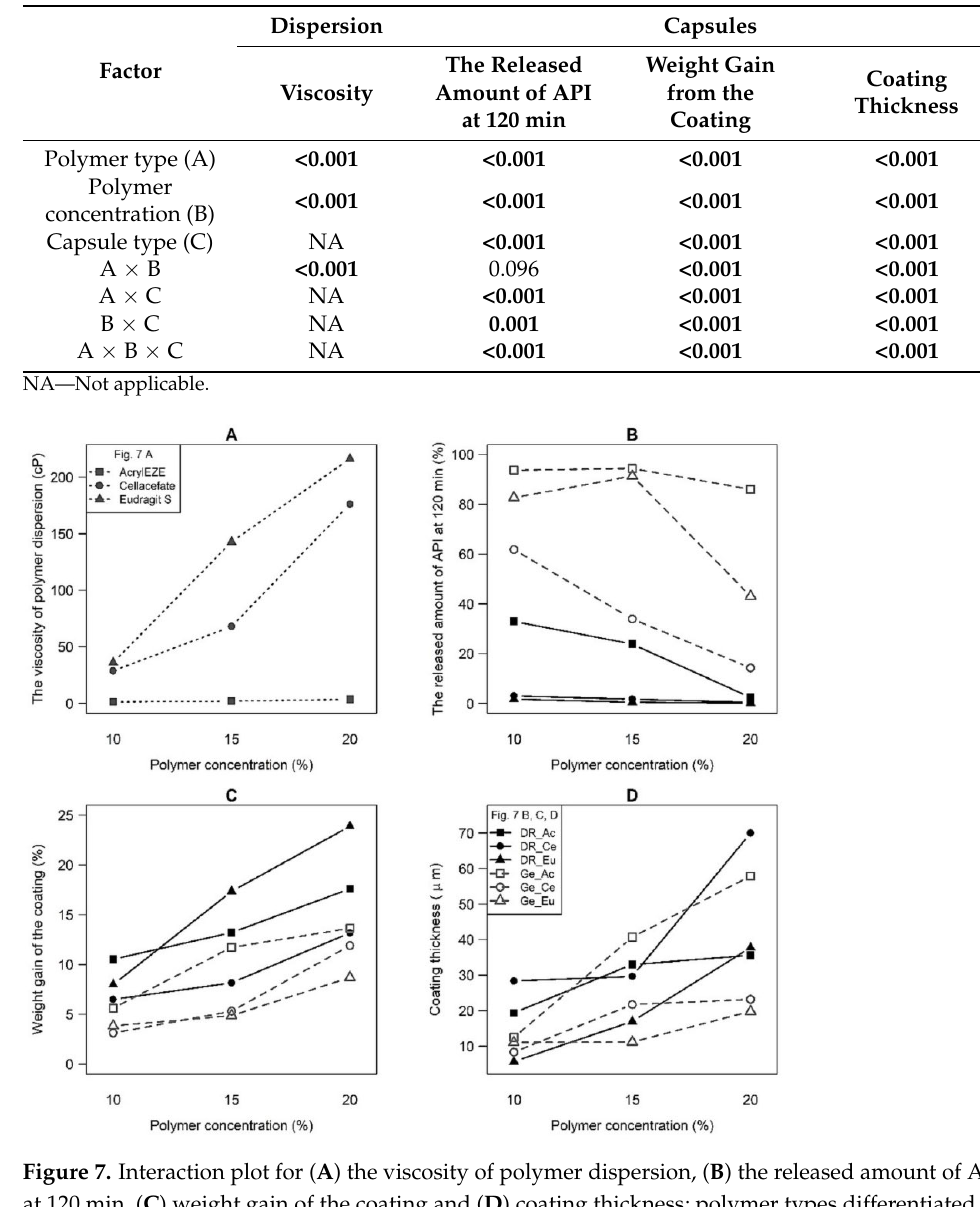
Table 5. The ANOVA table for evaluating the entire data set is p -values (significant effects are indicated in bold).